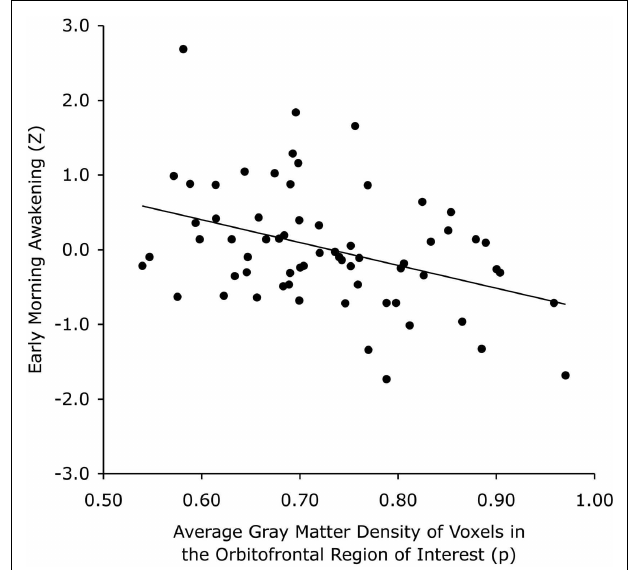
FIGURE 2 | Scatterplot showing that individuals (represented by a dot) with less GM in a cluster compatible with the border of areas 13L and 47/12M of the left orbitofrontal cortex are more likely to experience earlier morning awakening. The solid line represents the linear regression